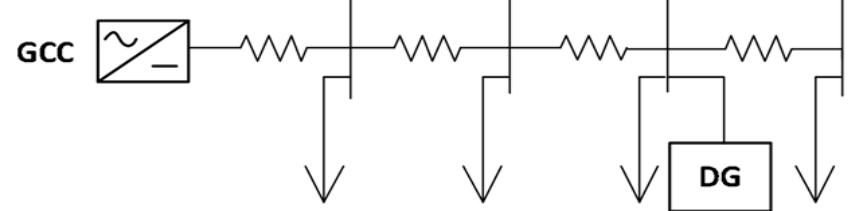
Figure 2. The proposed voltage control topology in a radial DC